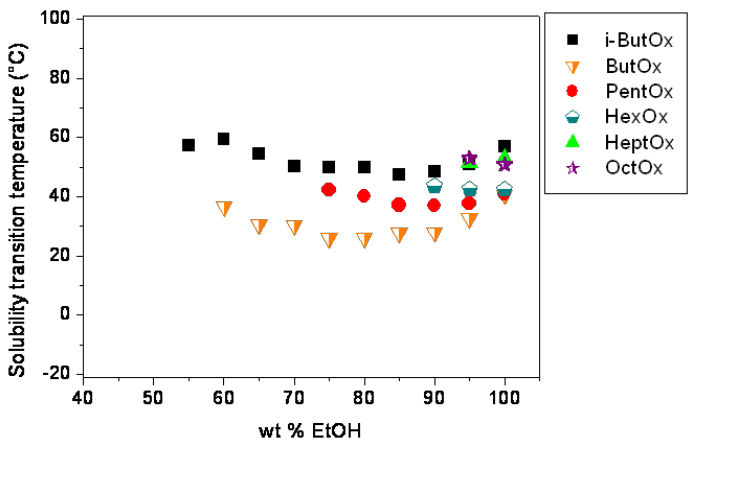
5. Dissolution temperatures in the first heating run for the poly(2-alkyl-2-oxazoline)s as function of wt% ethanol (5